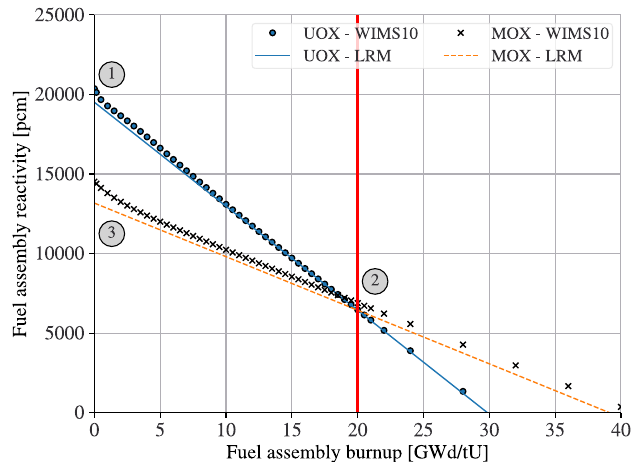
Fig. 3. Calculation of the required Pu content using the Linear Reactivity Model for an equivalence request at an end-of-cycle burnup of 20